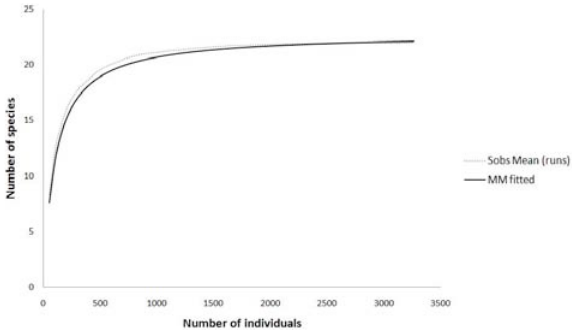
Figure 2 (a): Species accumulation curve – individuals vs. species richness (dotted grey line indicates observed species mean and black solid line indicates Michaelis-Menten